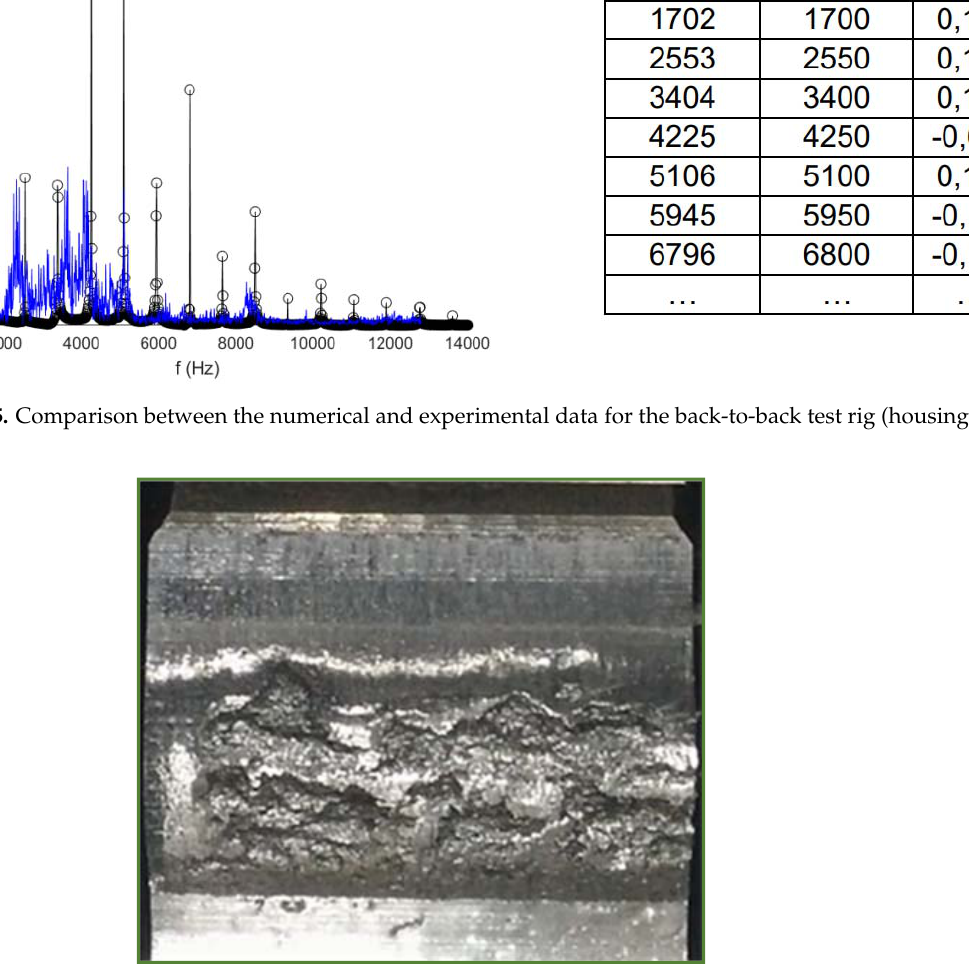
Figure 5. Comparison between the numerical and experimental data for the back-to-back test rig (housing).